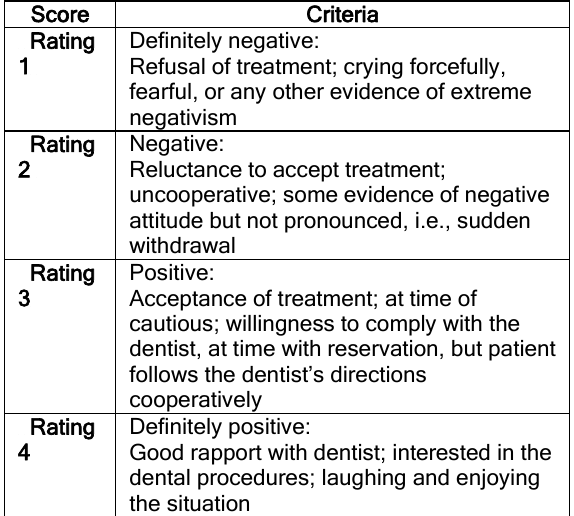
Table (2): Criteria for classifying debris (14)